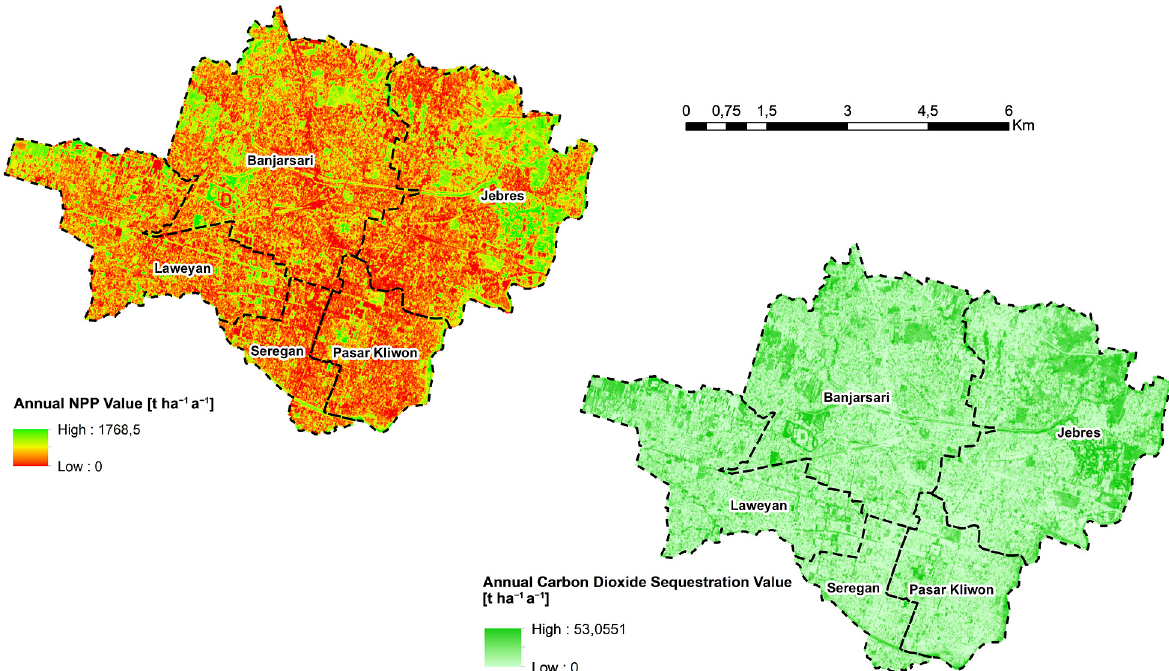
Fig. 8. Distribution of annual net primary productivity (NPP) and carbon dioxide sequestration in Surakarta